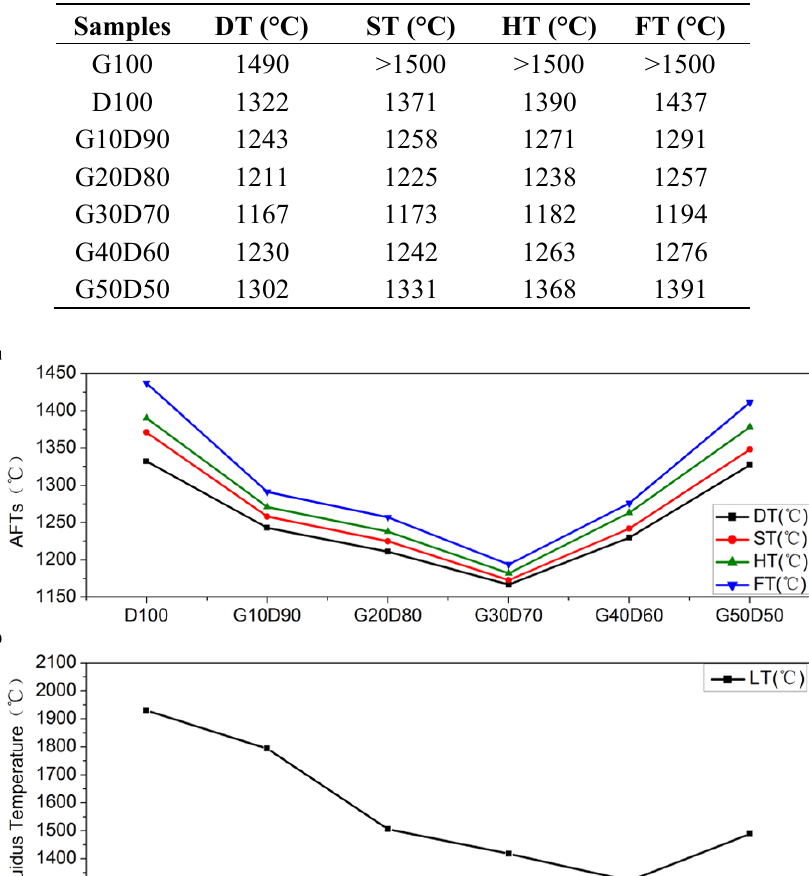
Table 2. Fusion characteristic temperature of the samples °C.